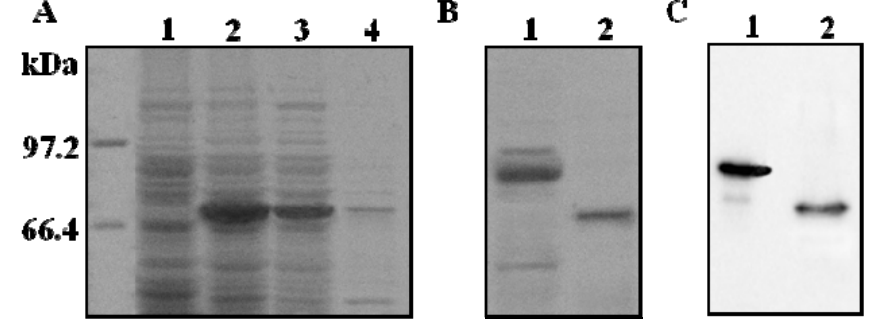
Figure 1. Expression analysis of recombinant ADAMTS1 in E. coli BL21